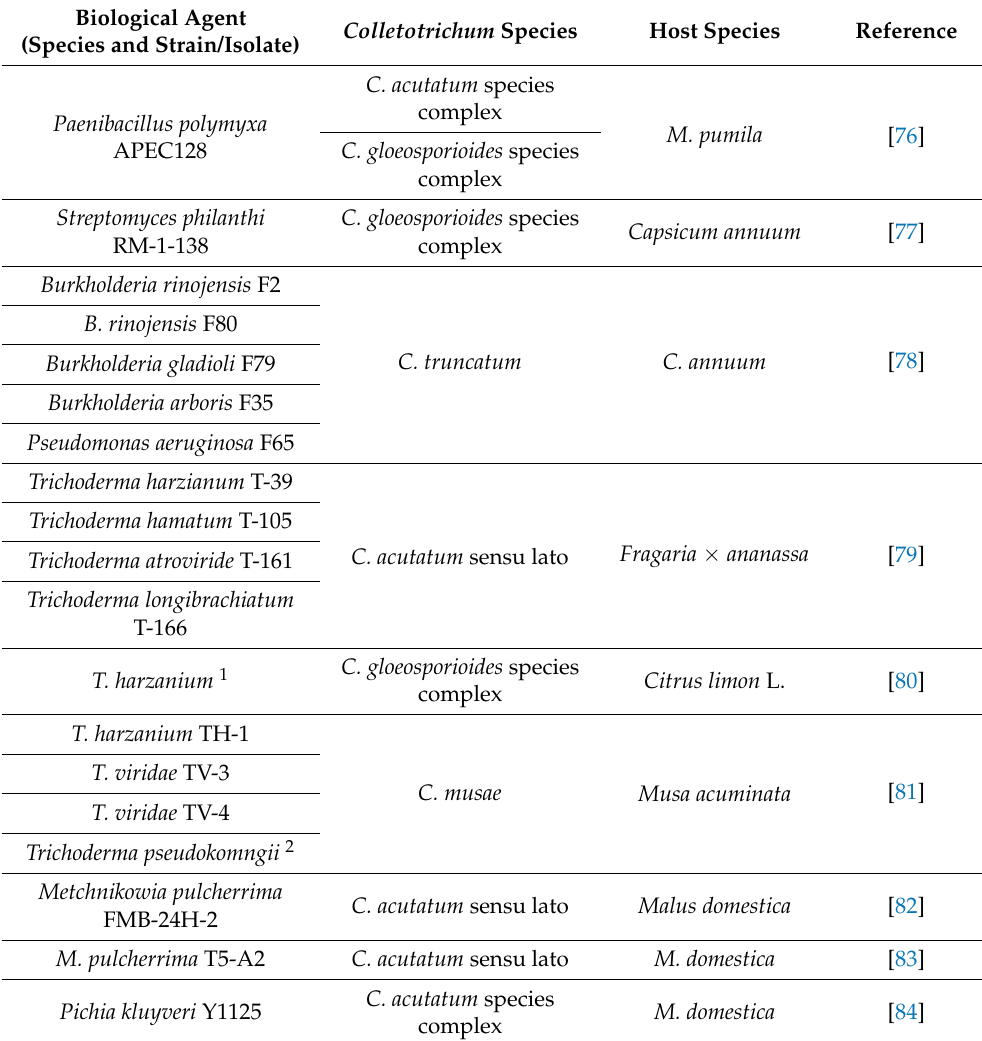
Table 1. Cont. Biological